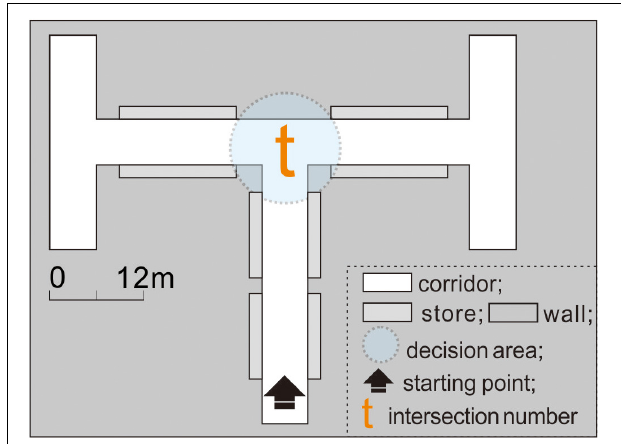
FIGURE 4 | In experiment 1, intersection t showed no difference in the corridor configuration attributes between the left and right sides.